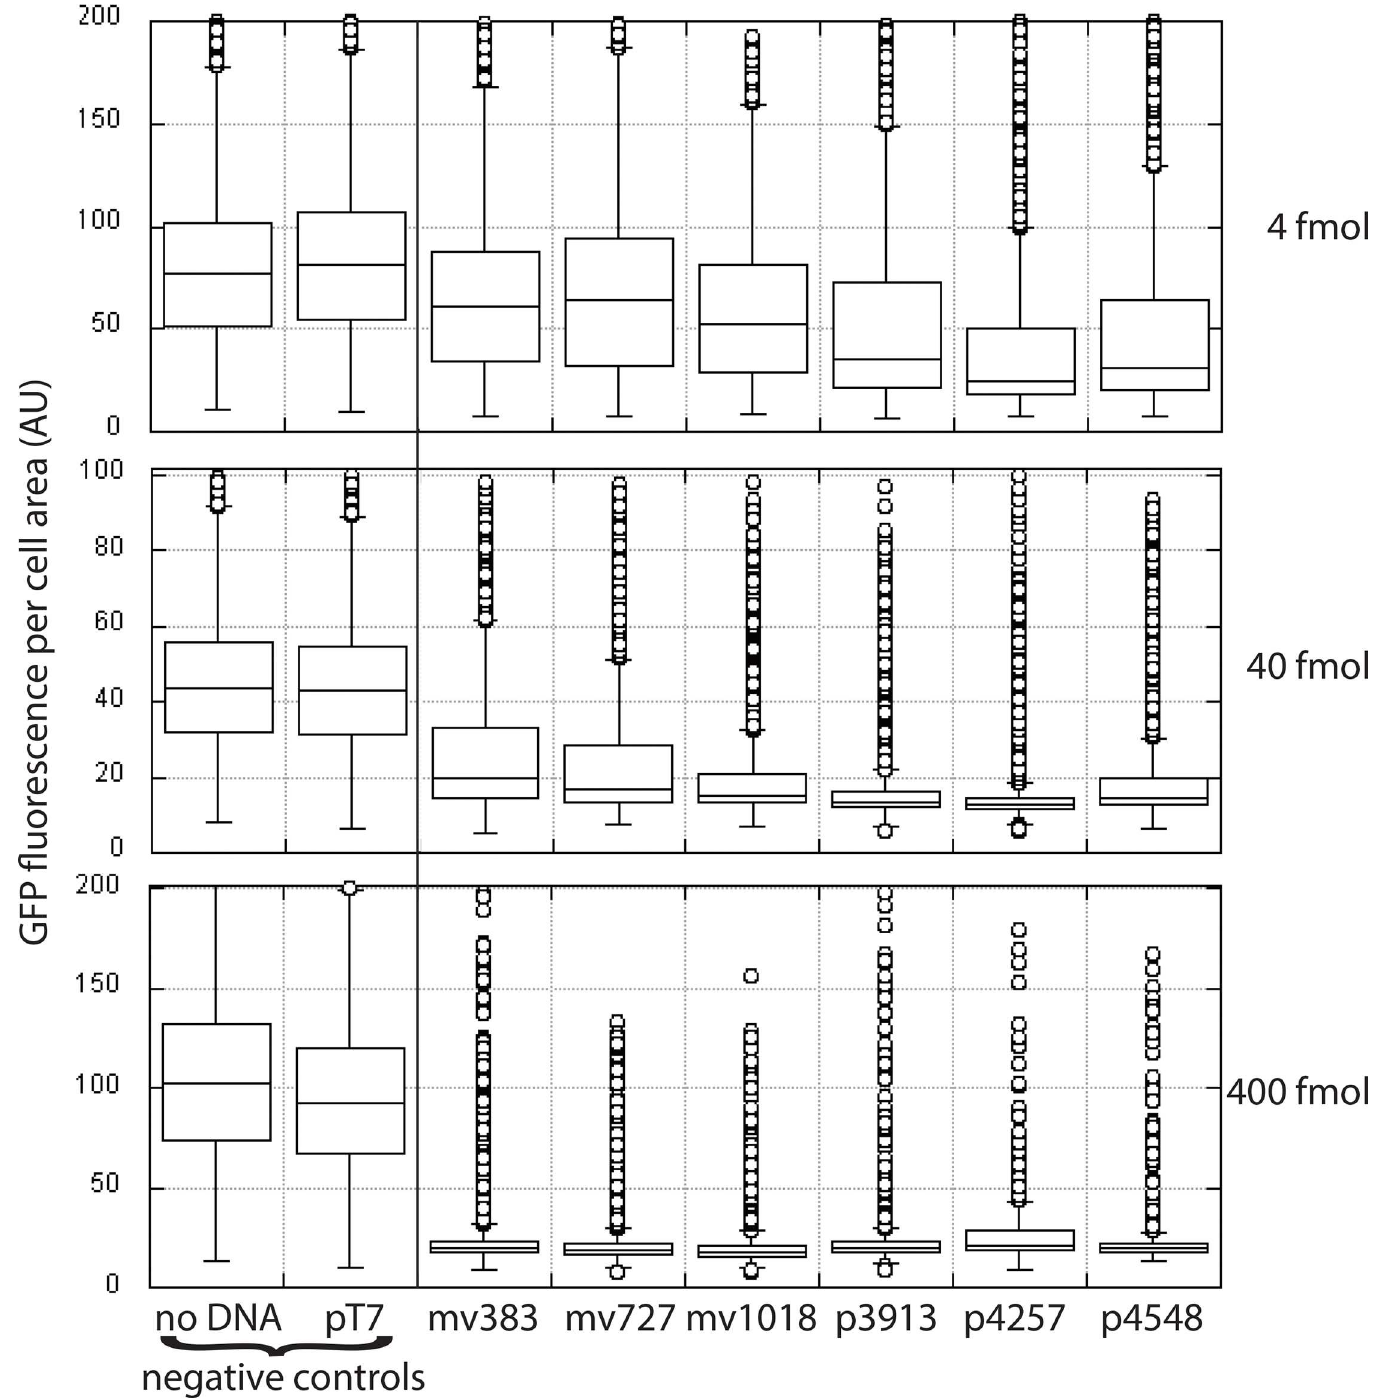
Fig 5. Fluorescence microscopy analysis of the effect of DNA vector length on GFP knockdown. 90,000 HeLa-GFP cells were transfected with the indicatedconcentrations of each vector, transferred after 24 hours to a 96-wellglass bottom plate, incubatedfor another24 hours, then fixed. Photographs of fields of cells from several wells from each transfectionwere taken. Images were analyzedusing myImageAnalysis[21] to quantify GFP fluorescence and size for each cell, encompassing several thousandcells in each transfection. Data were plotted using a Tukey box plot where each outlier cell, definedby having a GFP per cell area more than 1.5 x interquartile range abovethe 75 th percentile,is denotedby a circle. Statistical differences were determinedusing a one-way ANOVA on ranks, post hoc Kruskal-Wallis test. In the top panel, all results except for those from mv383 and mv727 were statistically different from each other. In the middlepanel, all but the two control sampleswere statistically significantly different from each other. In the bottom panel, all transfected cells were statistically significantly different from the controls, but only results for cells transfected with mv1018 differed from the other vectors.